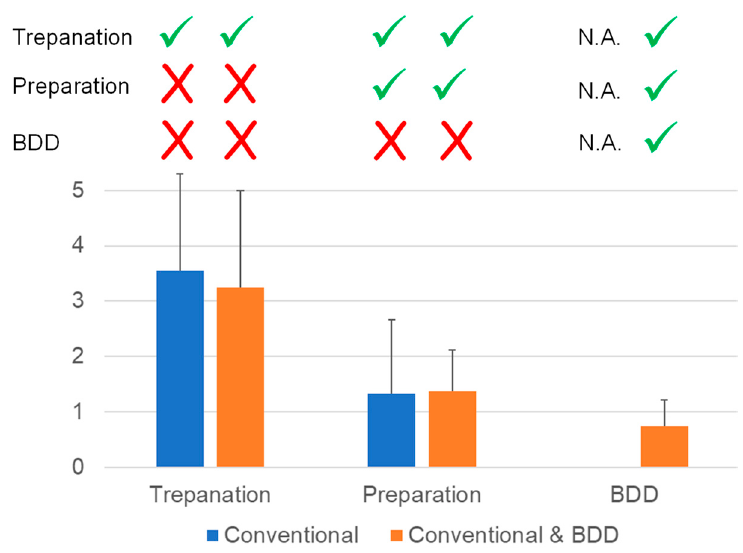
Figure 6. Ratings of bacterial growth following conventional endodontic treatment and endodontic treatment with additional BDD application. Electrochemical disinfection allowed for a further reduction in bacterial load. Meanings: (cid:88) Treatment step carried out; X Treatment step not carried out.